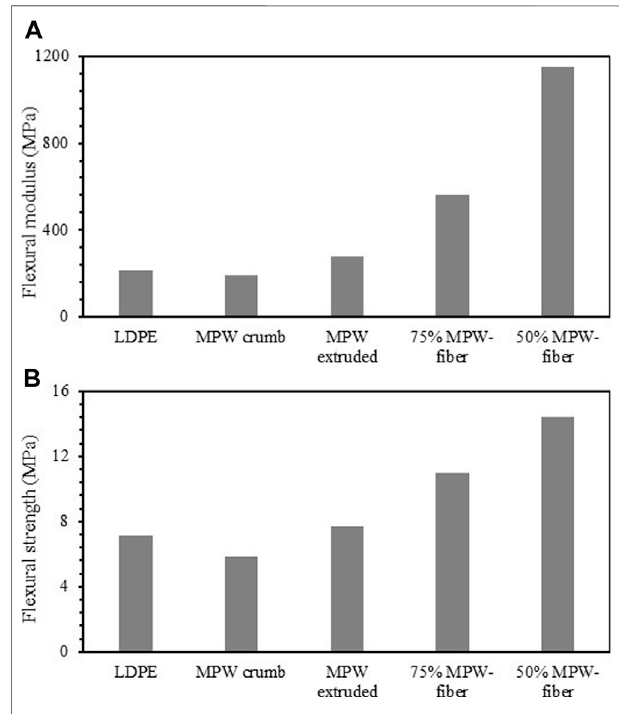
FIGURE 12 | (a) Flexural modulus and (b) Flexural strength of LDPE, MPW crumb, extruded MPW, extruded MPW- fi ber (50/50 and